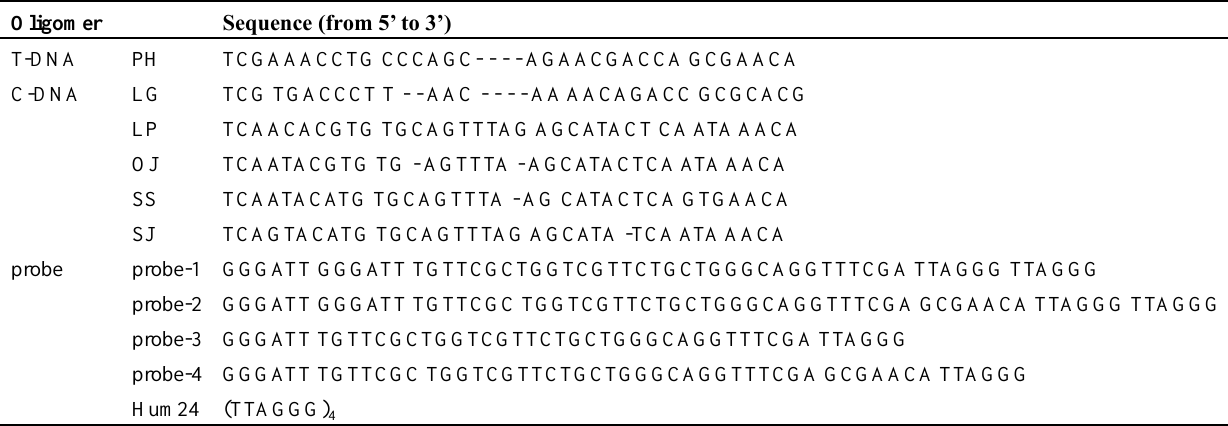
Table 1. Sequences of the oligonucleotides used in the assembly of the G-quadruplex DNAzyme MB